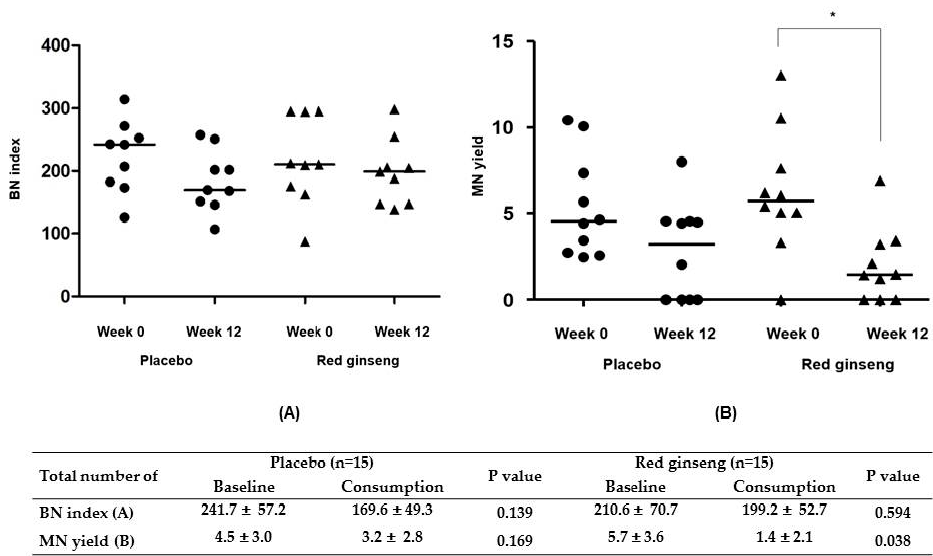
Figure 1. Comparison of ( A ) binucleated cells (BN) index and ( B ) micronuclei (MN) yield between placebo and red ginseng groups.